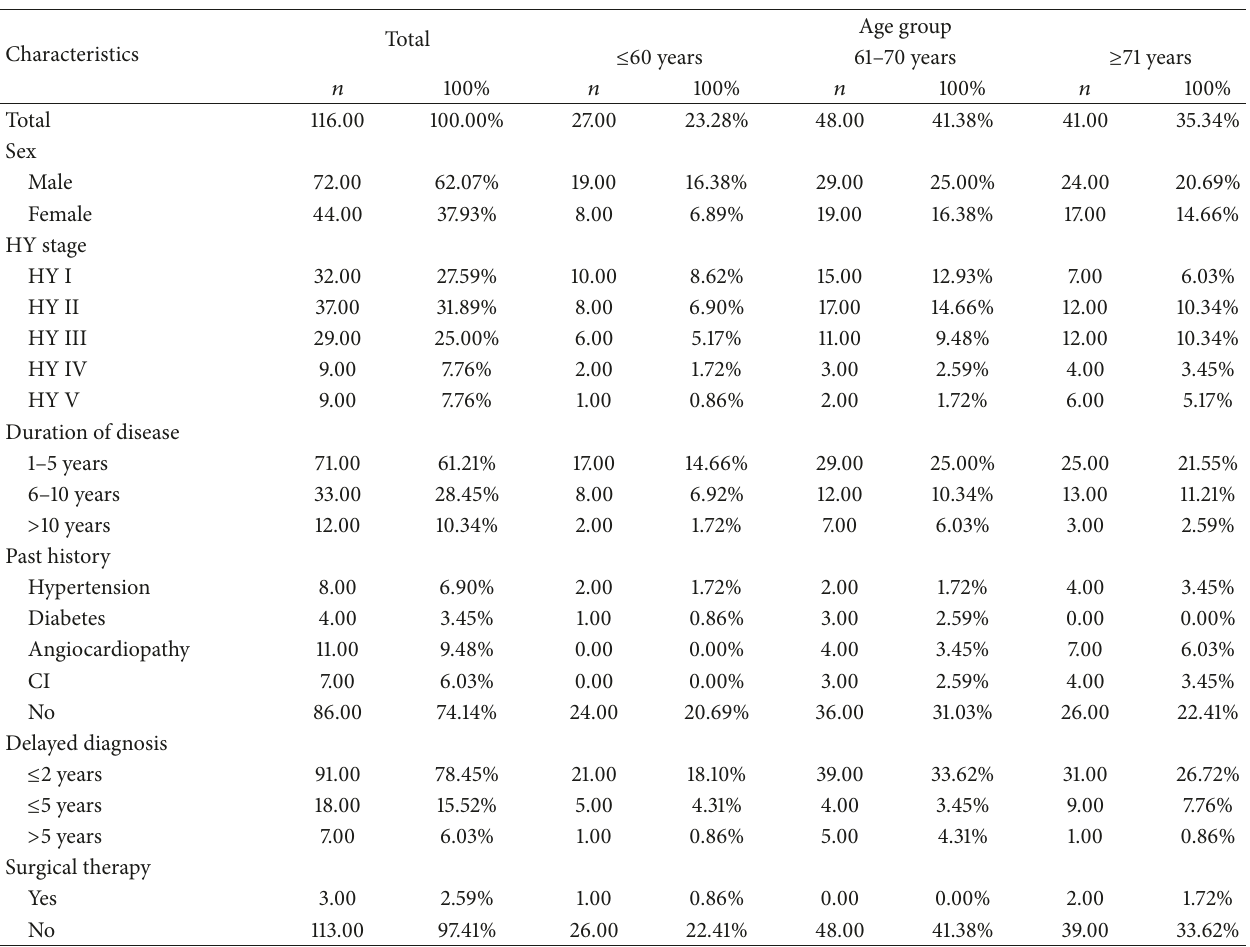
Table 1: Demographic characteristics and clinical parameters of the 116